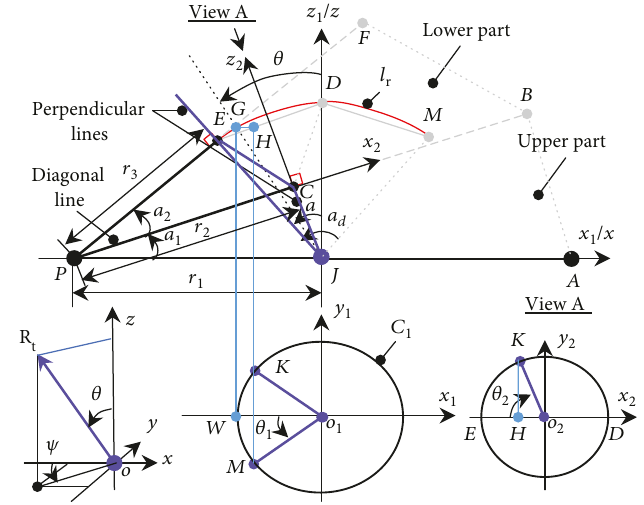
Figure 5: An equiangular dual-perpendicular